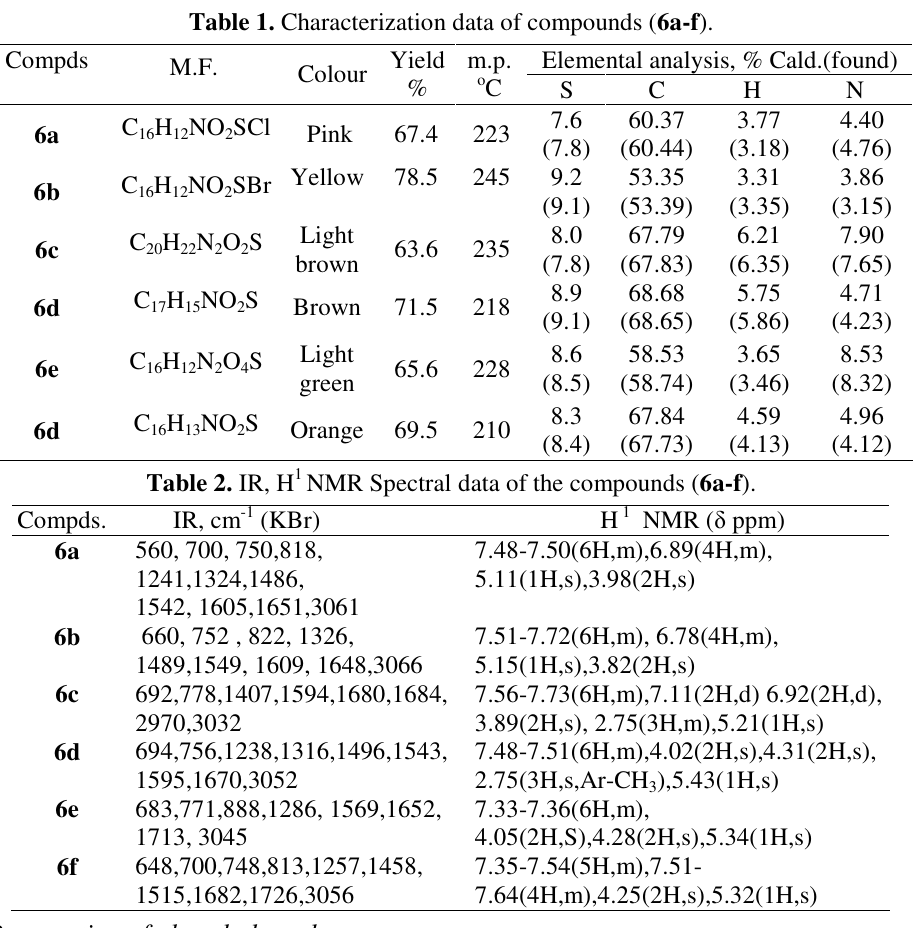
Table 1. Characterization data of compounds ( 6a-f ).